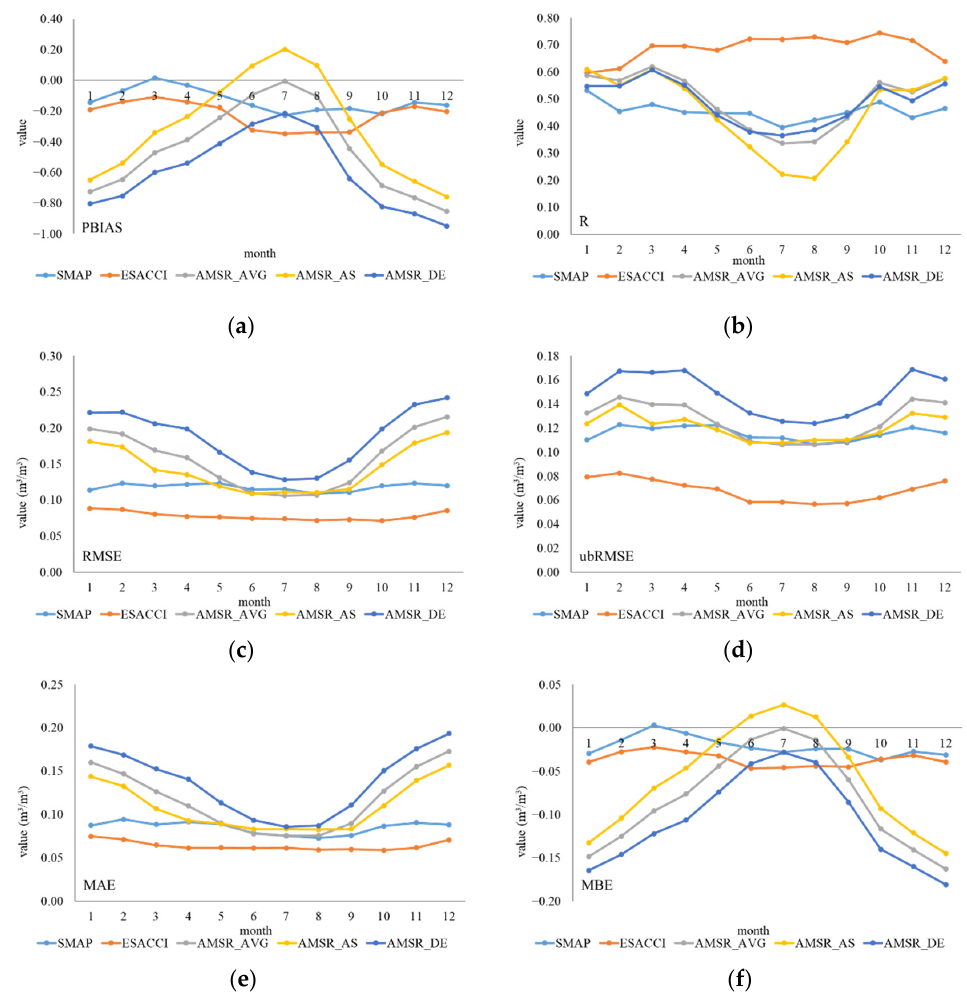
Figure 4. Performance of six indicators of five products at different months. ( a ) PBIAS; ( b ) R ( p -value < 0.0001); ( c ) RMSE; ( d ) ubRMSE; ( e ) MAE; and ( f ) MBE .